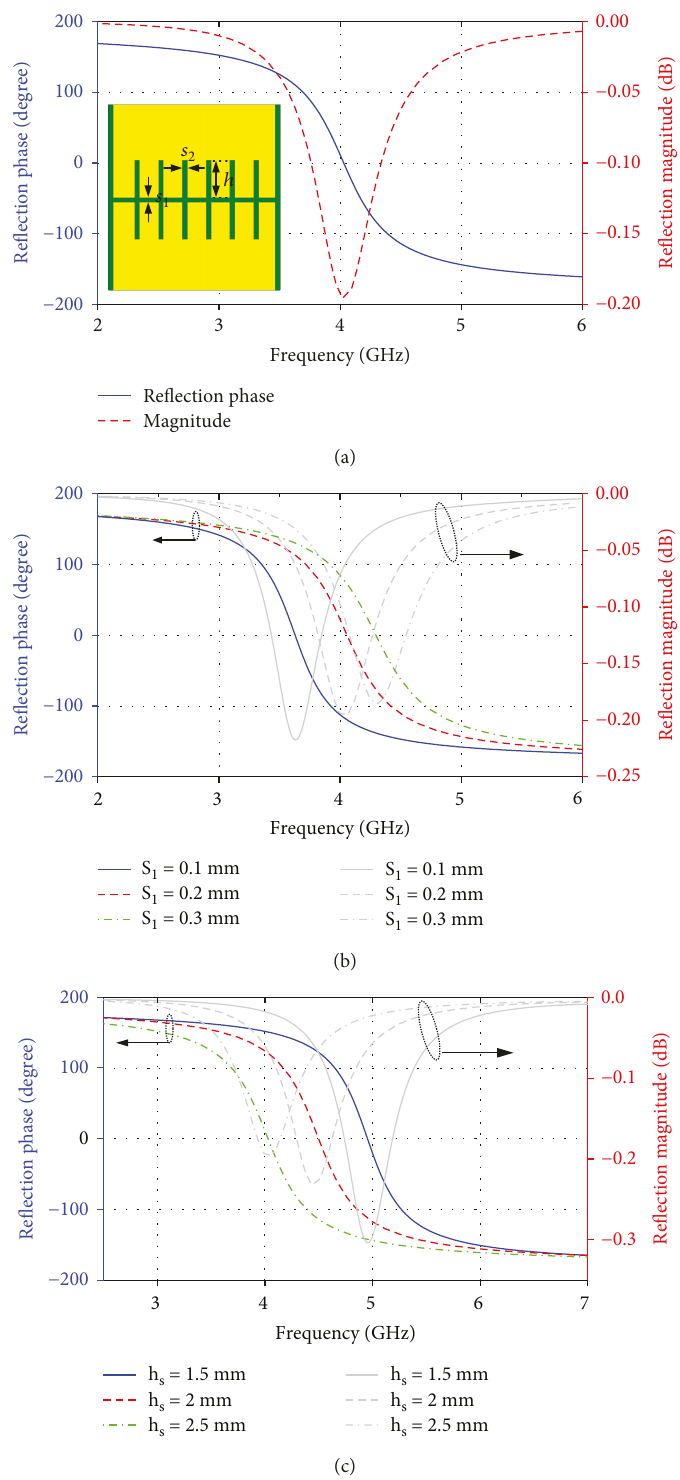
Figure 3: (a) Re fl ection phase and magnitude of the unit cell. (b) Parametric study on slot gap s substrate h s